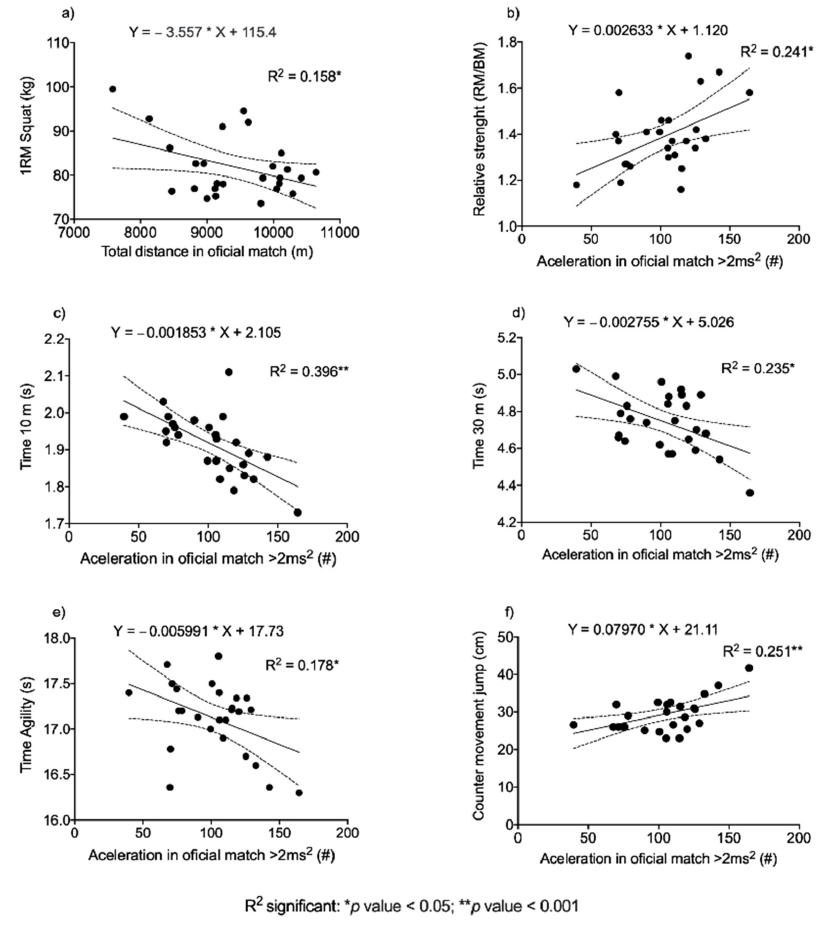
Figure 6. Simple linear regressions between neuromuscular variables and official match performance. ( a ) 1RM squat with Total distance; ( b ) Relative Strenght with Aceleration; ( c ) Time 10 m with Aceleration; ( d ) Time 30 m with Aceleration; ( e ) Time Agility with Aceleration; ( f ) Counter movement jump with Aceleration.